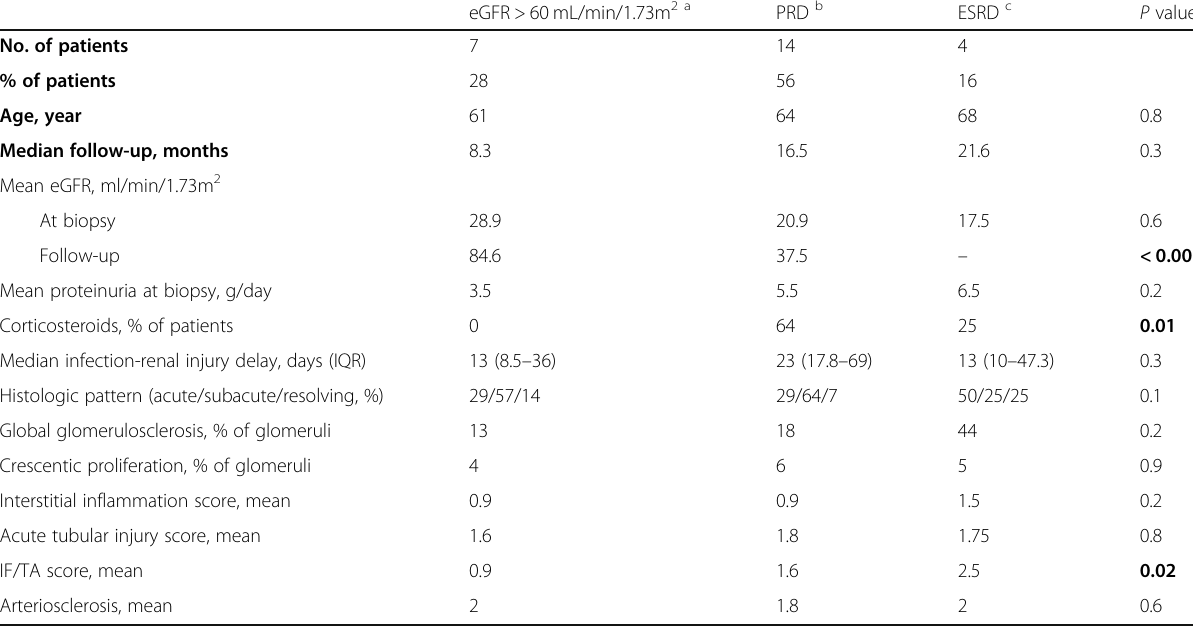
Table 5 Outcome and prognostic factors (25